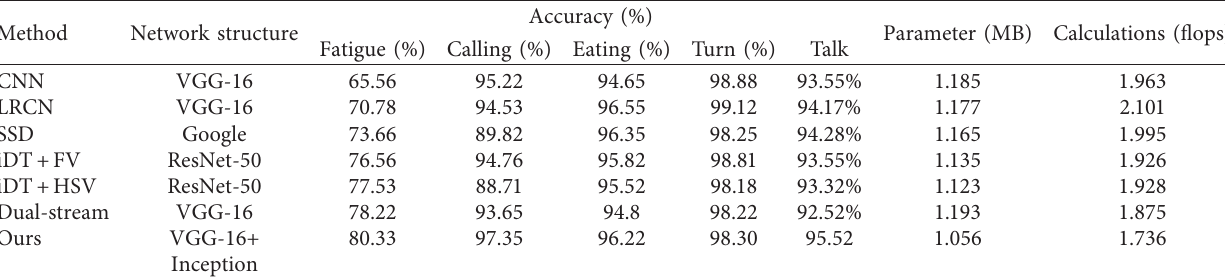
Table 3: Test results of different methods in self-built database.